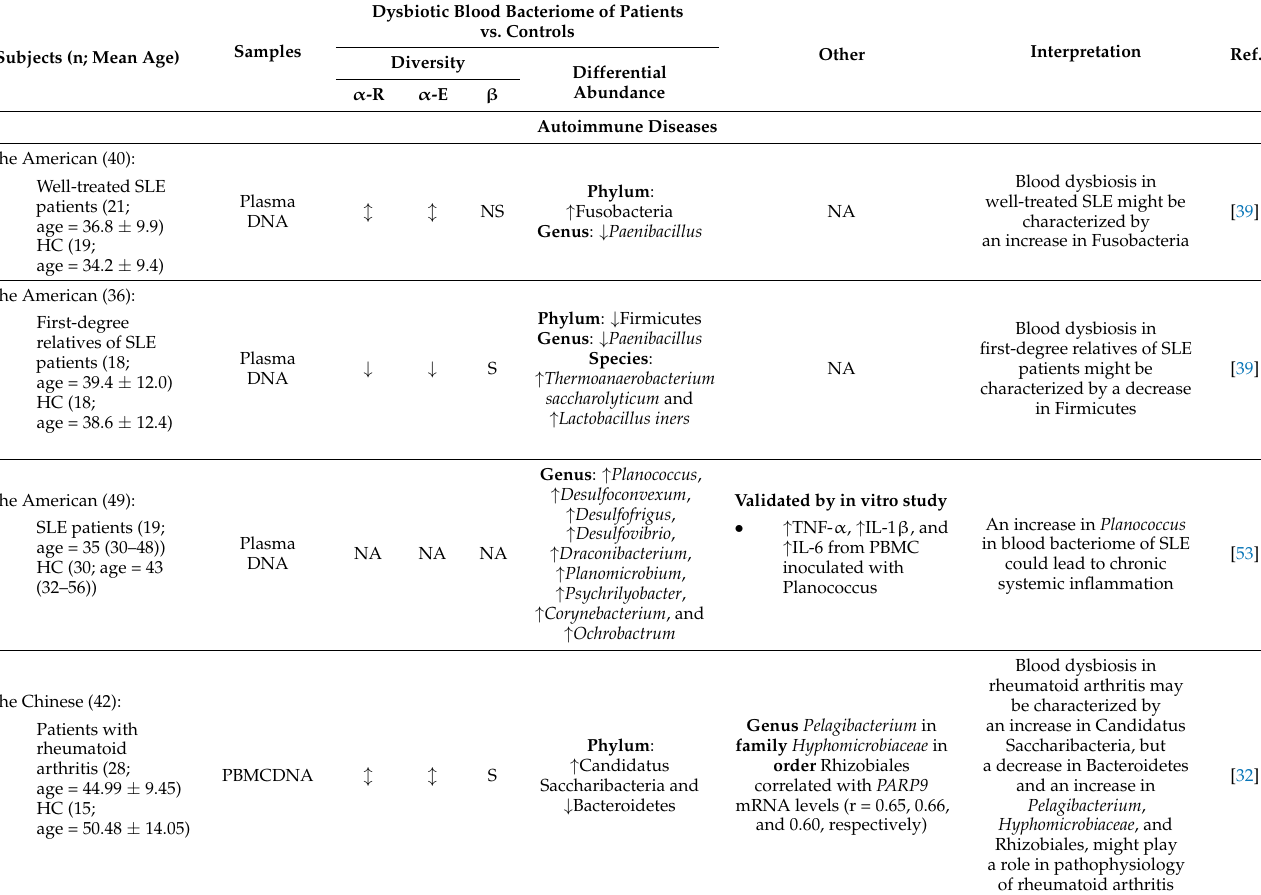
Table 6. Blood Bacteriome Dysbiosis Profiles in Immunity-Mediated